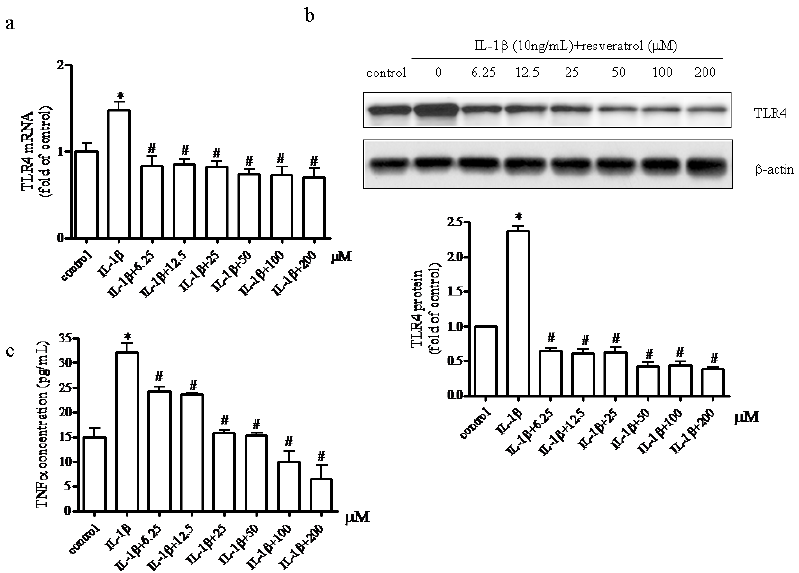
Figure 2. Effect of resveratrol on TLR4 mRNA and protein synthesis and TNFα production. ( a ) Serum-starved (0.5% FCS) human articular chondrocytes were